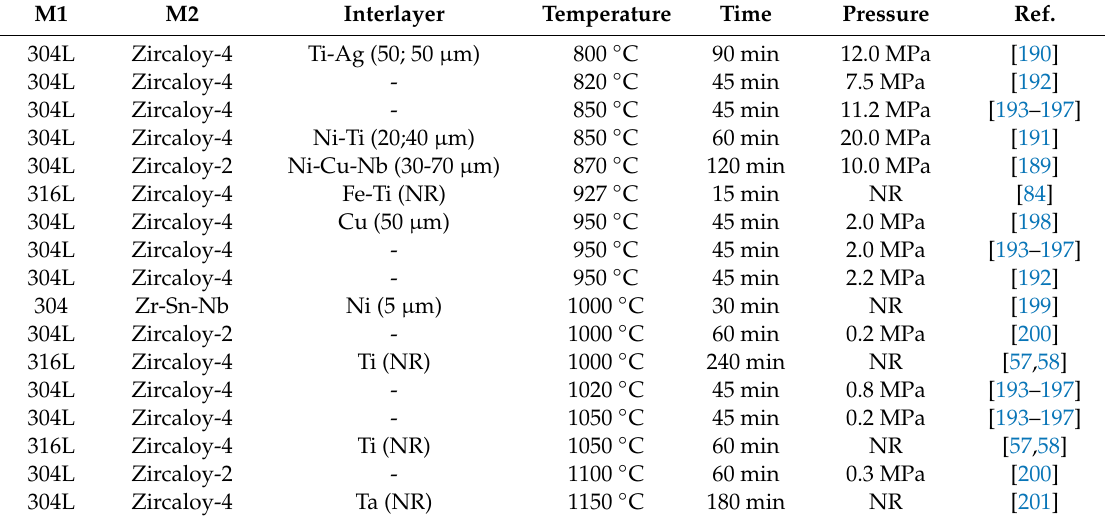
Table 8. Reported parameters for di ff usion bonding and TLP bonding of 304 and 316 to Zircaloy and Zr-Sn-Nb.